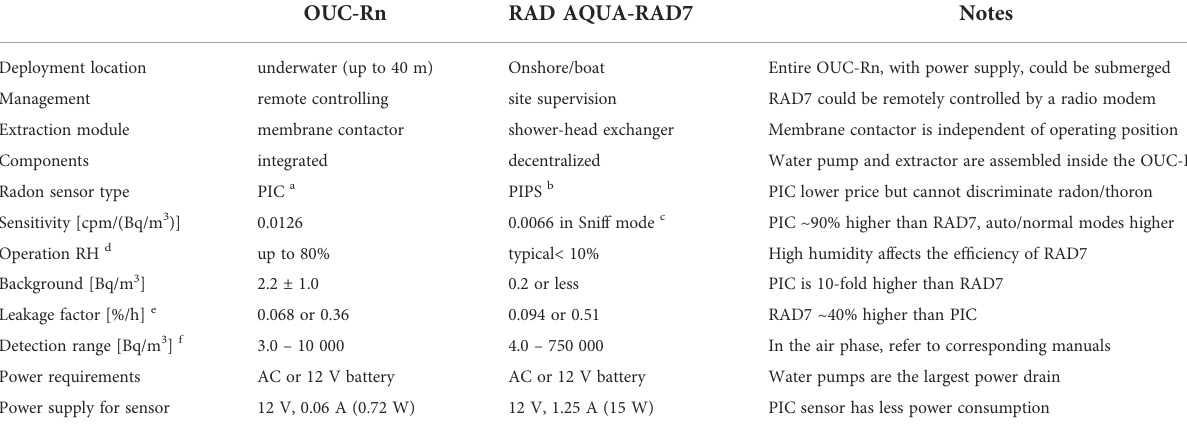
TABLE 1 Comparison of the OUC-Rn versus RAD AQUA-RAD7 radon